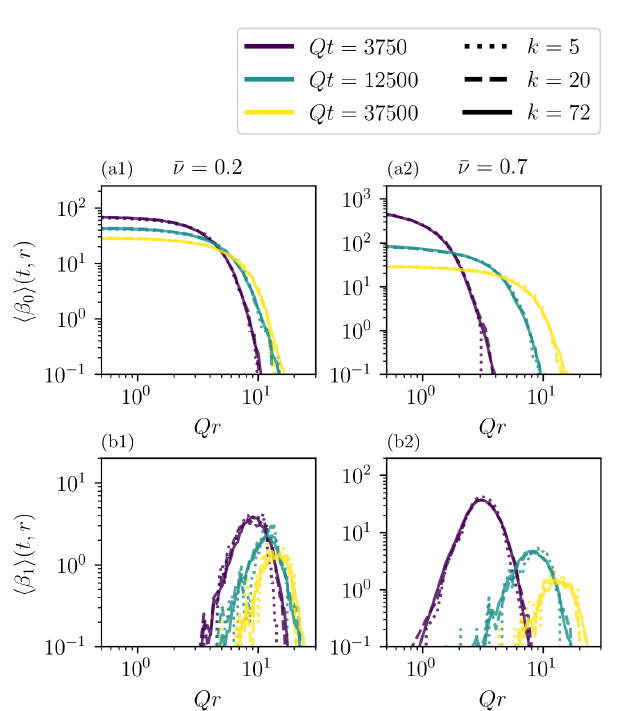
Figure 17: Betti number distributions in the infrared varying with time, displayed for ¯ ν -values and numbers of samples to average, k , as